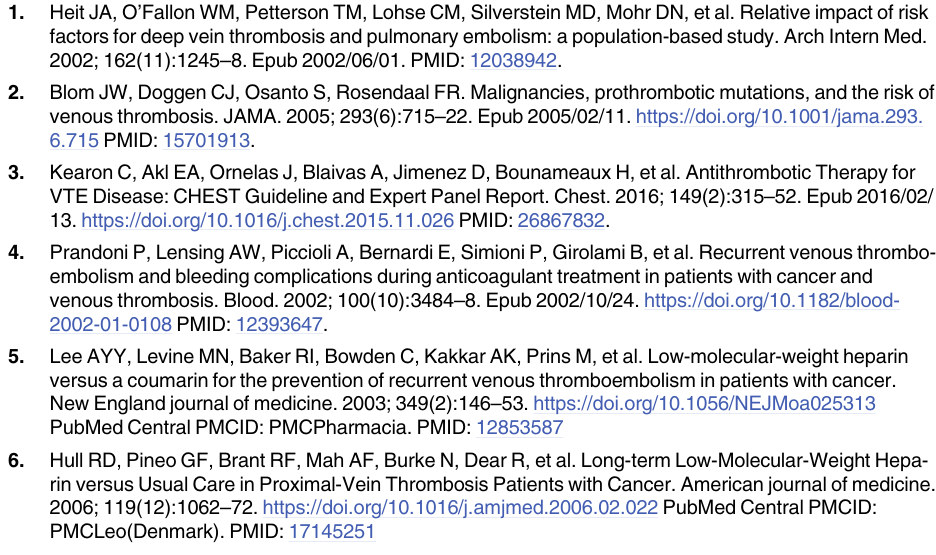
S7 Table. Comparison between direct and indirect evidence. S8 Table. Heterogeneity and inconsistency